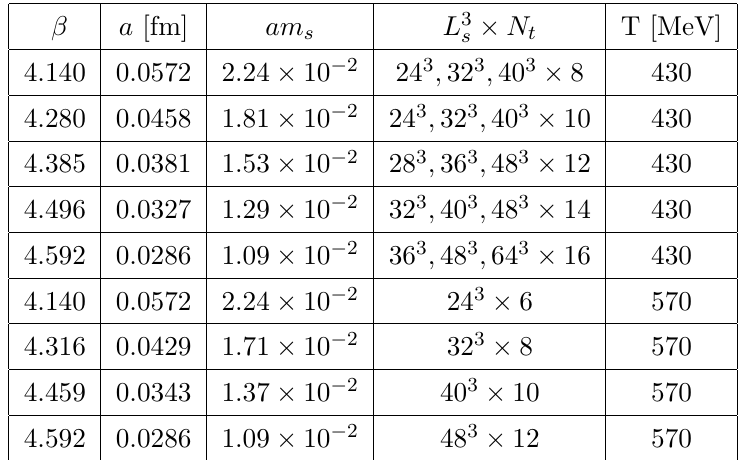
Table 1 . Simulation parameters used in this work. Bare parameters have been (cid:12)xed according to refs. [61, 62] or spline interpolation of data thereof. The systematic uncertainty on the lattice spacing determination is 2{3% and the light quark mass is (cid:12)xed by m s =m l = 28 :